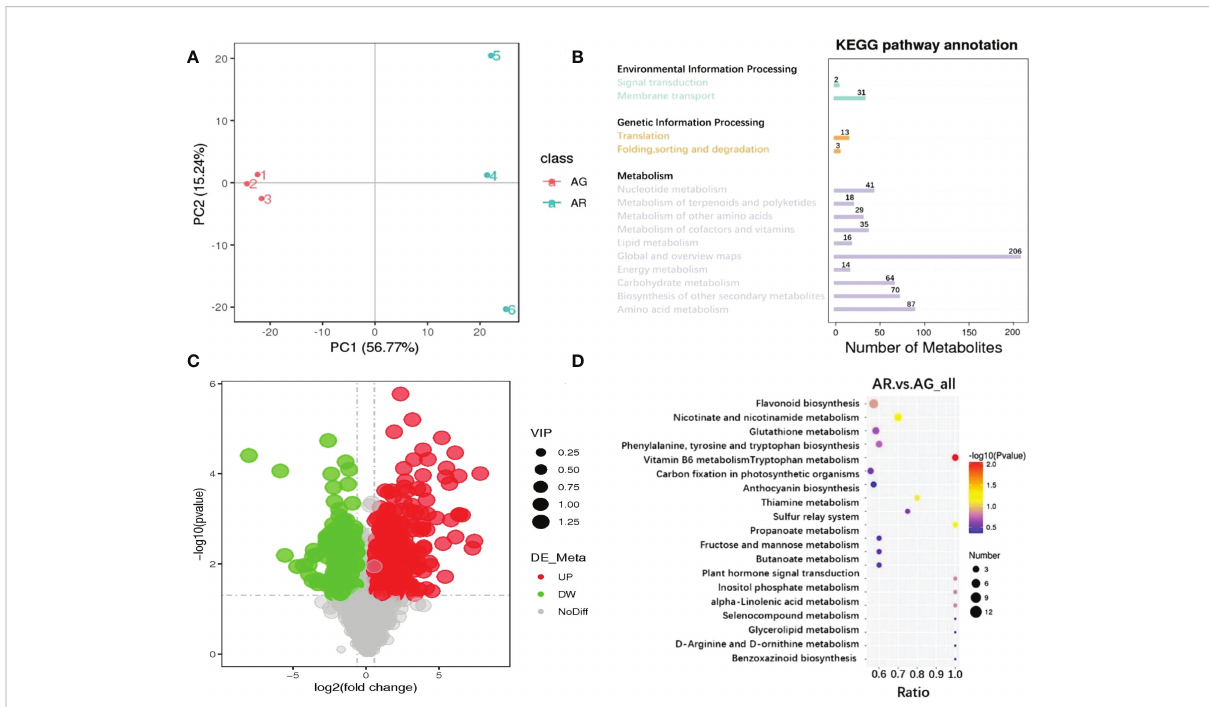
FIGURE 3 Metabolite analysis of A p. subsp. mono leaves based on targeted metabonomics technology. (A) PCA analysis of metabolites in the leaves of A p. subsp. mono. (B) KEGG classi fi cation map of metabolites from the leaves of A p. subsp. mono. (C) Volcanic map of differential metabolites in the leaves of A p. subsp. mono (AR vs. AG). (D) Enrichment analysis of KEGG (AR vs. AG); differential metabolites in the leaves of A p. subsp. mono